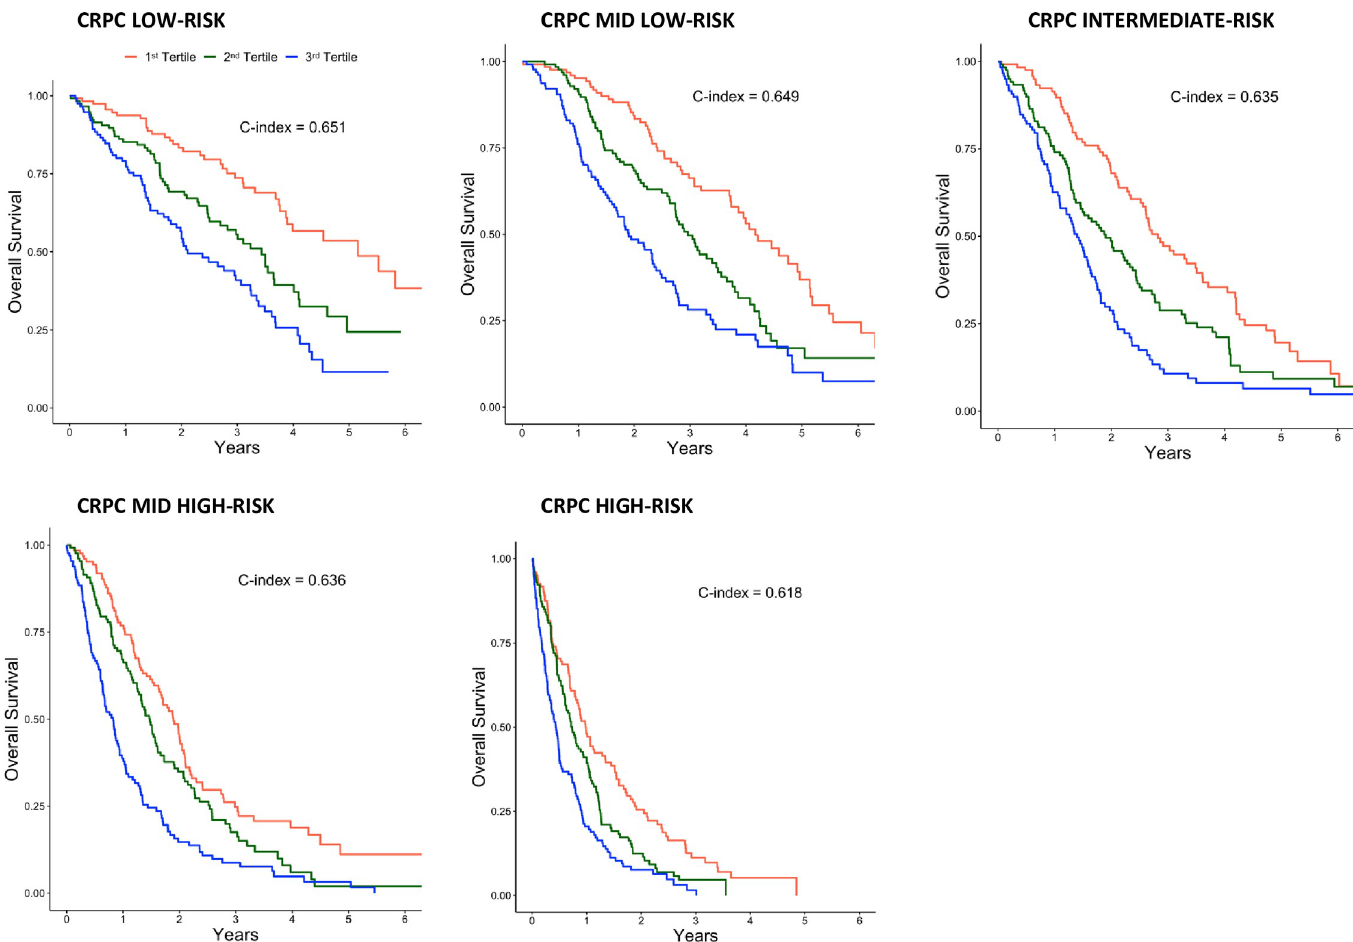
Fig 2. Overall survival in 1885 men with castration resistant prostate cancer (CRPC) in five risk categories and stratified in tertiles of the Drug Comorbidity Index for CRPC (DCI-CRPC).